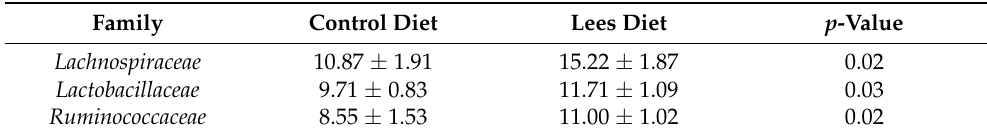
Table 3. Differences regarding relative abundance (%) of bacteria from the phylum Firmicutes between rats with control and lees diet. Values are mean ± standard deviation.